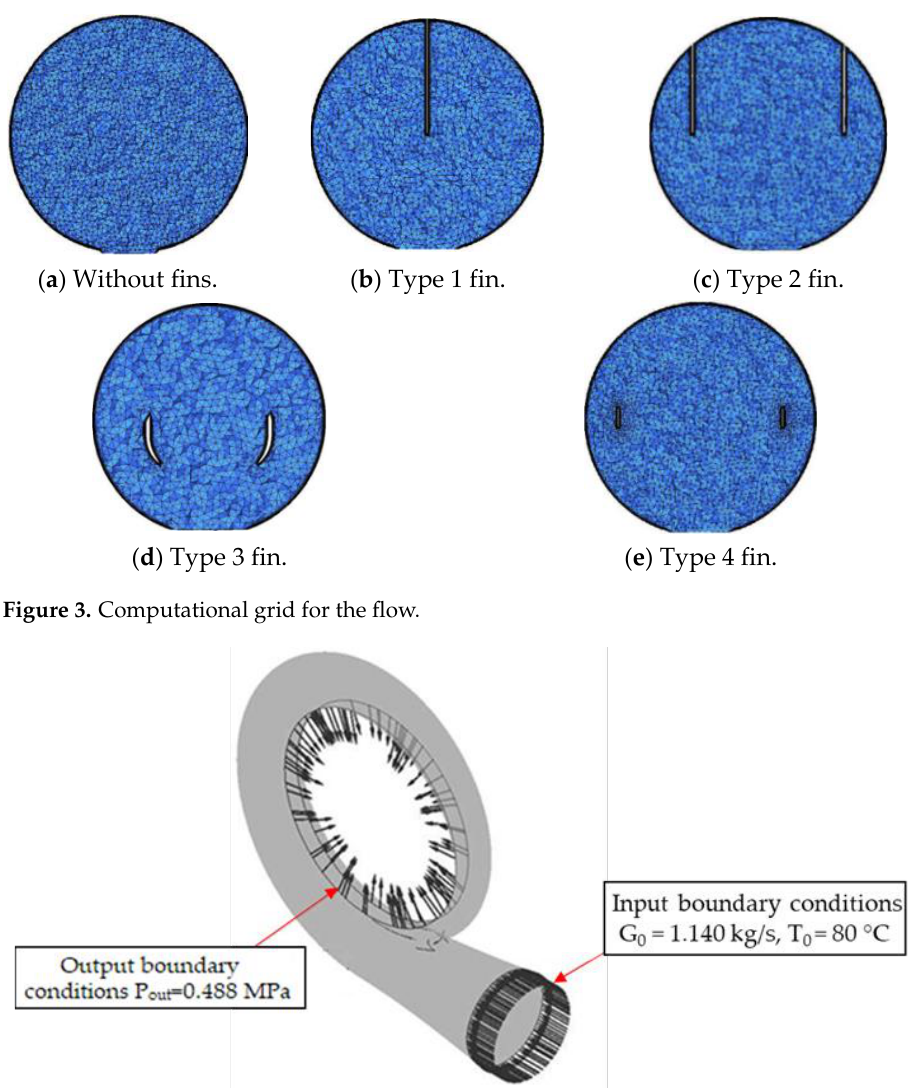
Figure 4. Boundary conditions of the model.